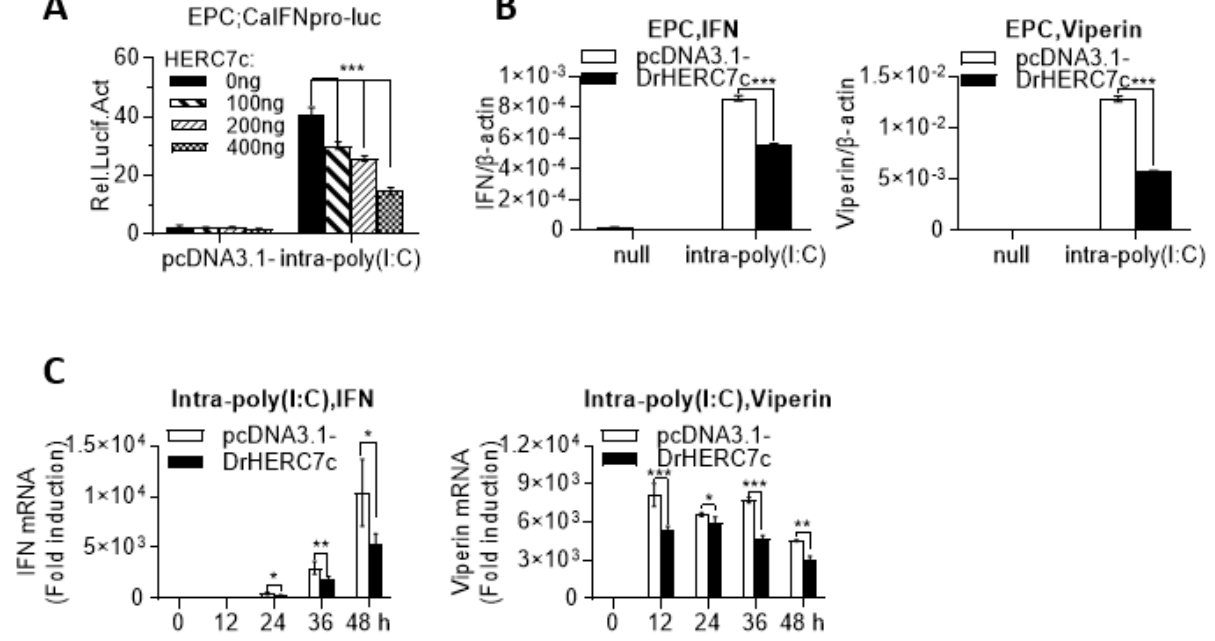
Figure 3. Zebrafish HERC7c suppresses intracellular poly(I:C)-triggered IFN response by luciferase assays. ( A ) Overexpression of zebrafish HERC7c inhibited fish IFN promoter activation by intracellular poly(I:C). EPC cells were cotransfected with 100 ng CaIFNpro-luc and increasing doses of zebrafish HERC7c for 24 h, followed by transfection with 1 µ g /mL poly(I:C). ( B , C ) Zebrafish HERC7c inhibited mRNA expression of cellular ifn and viperin in EPC cells by intracellular poly(I:C). EPC cells were transfected with 2 µ g of zebrafish HERC7c or pcDNA3.1- as control. After 12 h, the cells were transfected again with 1 µ g/mL poly(I:C). At 36 h post infection ( B ) or at different time points ( C ), cells were sampled for RT-PCR analyses of cellular ifn and mx transcription. Error bars represent SD obtained by measuring each sample in triplicate. (*** p < 0.001, ** p < 0.01, * p < 0.05).